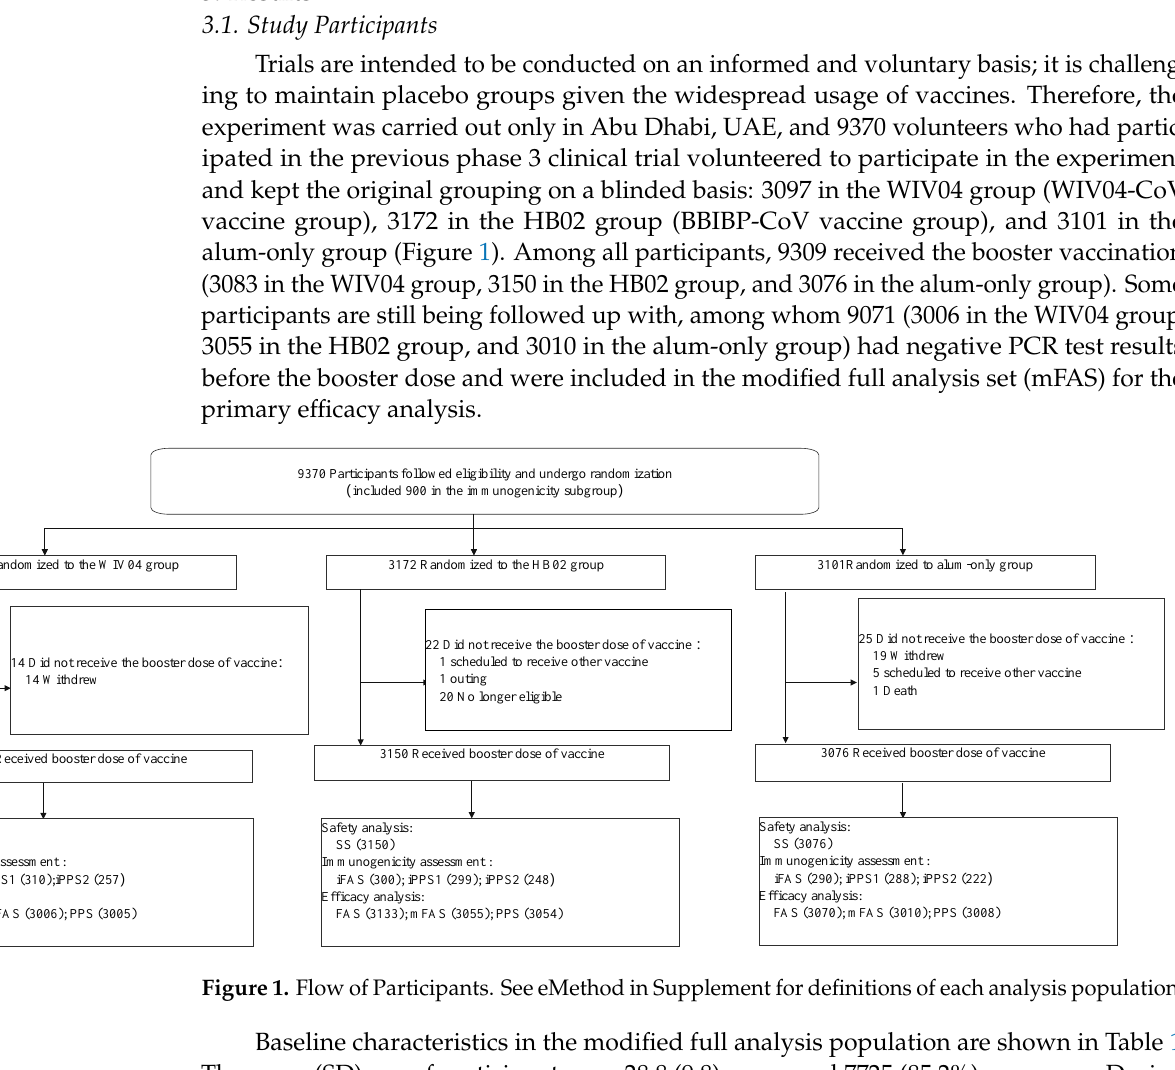
Baseline characteristics in the modified full analysis population are shown in Table